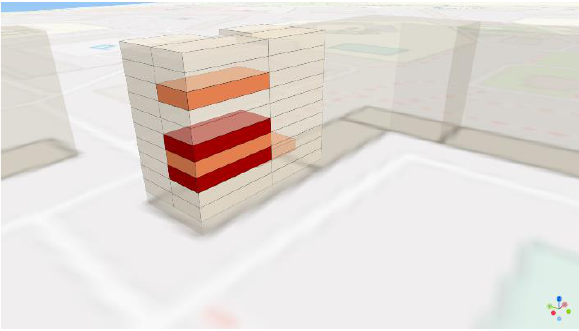
Figure 8 . Linking hotbeds to apartments according to floor